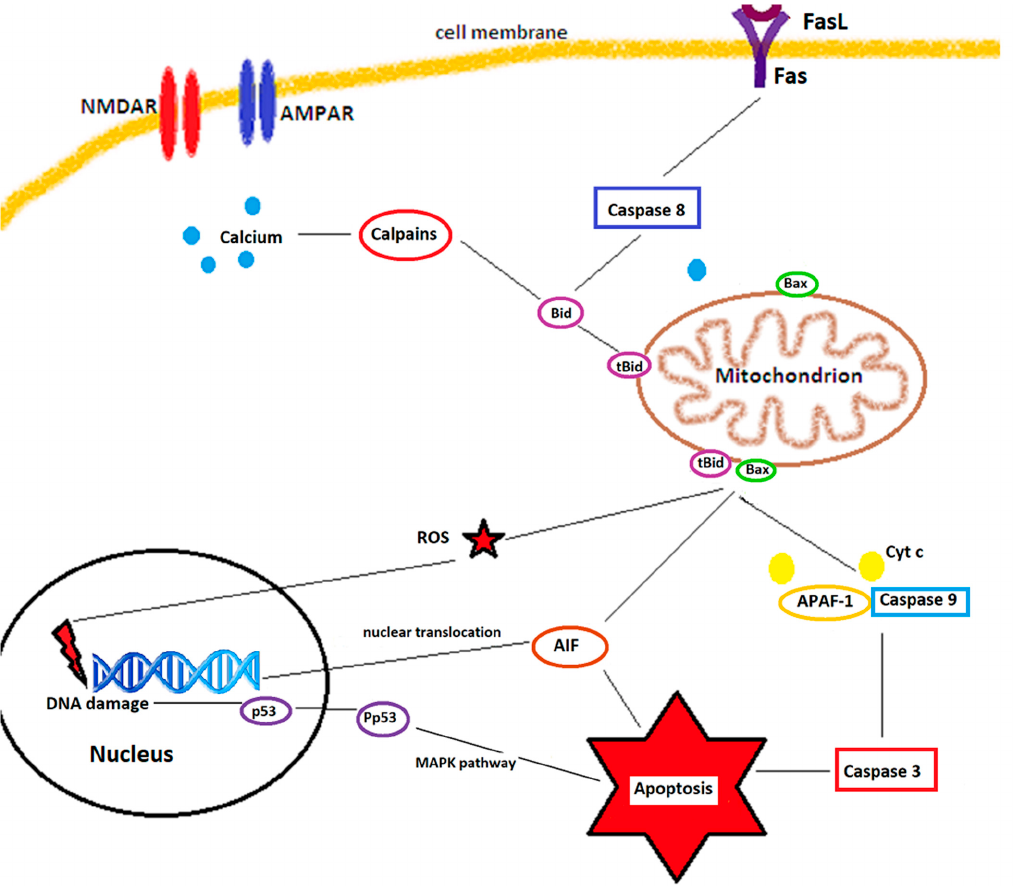
Figure 1. Mechanisms of ischemic neuronal cell death. Stimulation of the NMDA receptors (NMDARs) and AMPA receptors (AMPARs) increases the cytosolic calcium, which activates calpains and causes mitochondrial dysfunction. Binding of Fas ligands (FasL) to Fas death receptors activates caspase 8. Calpains and caspase 8 truncate Bid into tBid, which interacts with Bax at the mitochondrial membrane leading to pore formation and release of cytochrome c (Cyt c), apoptosis inducing factor (AIF), and reactive oxygen species (ROS). ROS and AIF, which translocate to the nucleus,